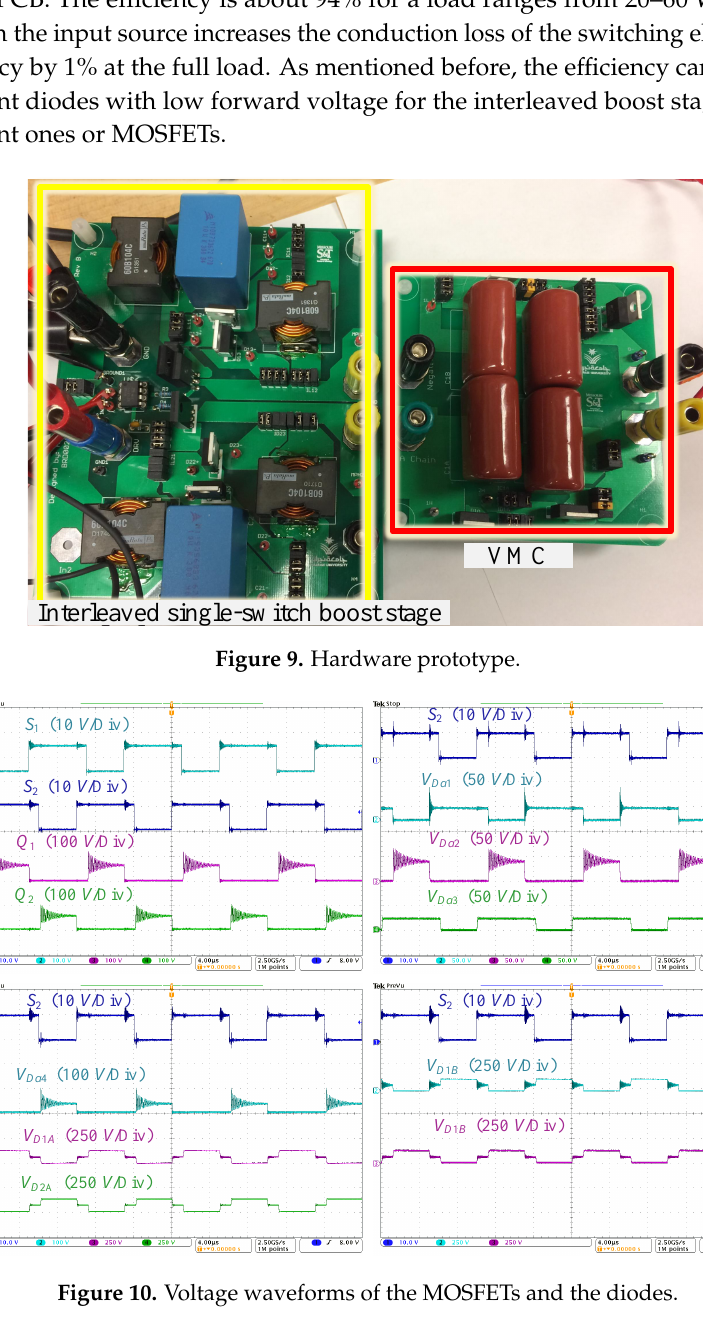
Figure 10. Voltage waveforms of the MOSFETs and the